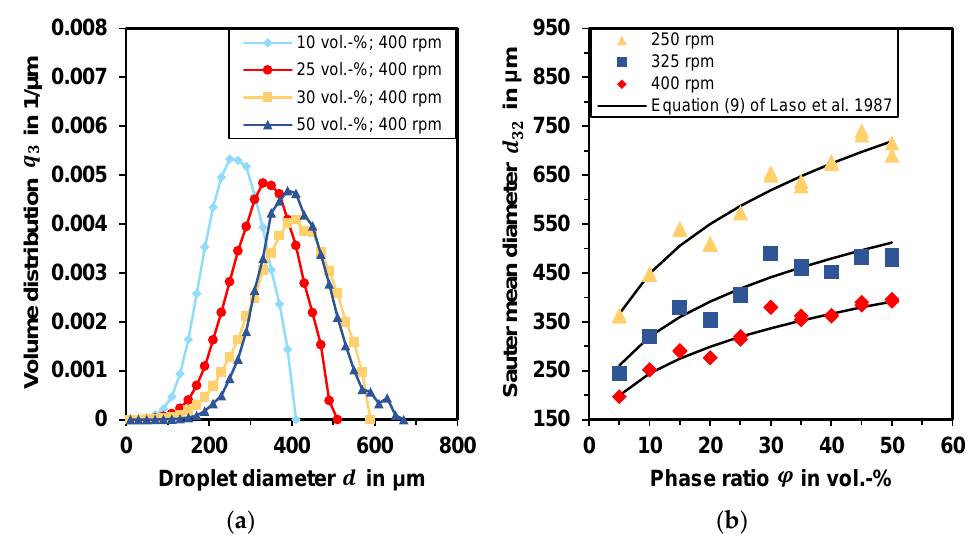
Figure 7. ( a ) Experimental volume distributions at different phase fractions, 𝑁 = 400 rpm. The lines are a guide to the eye; and ( b ) experimental Sauter mean diameters of both experiments at different rpm (model of Laso et al. [51] with the coefficients from Table 2). Table 2. Coefficients and confidence intervals for Equation (8) [50] and Equation (9) [51].